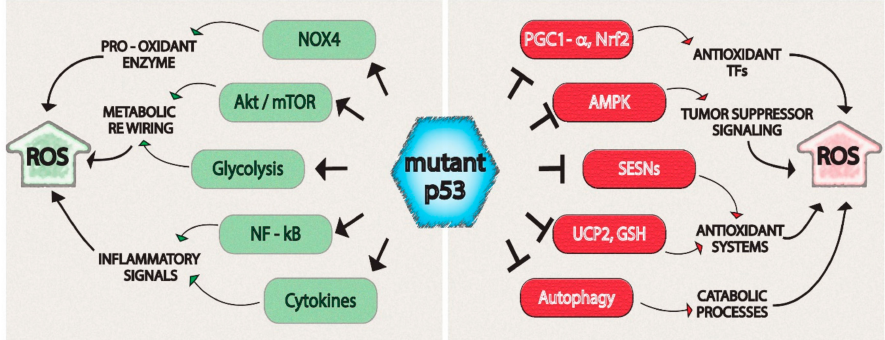
Figure 1. Gain-of-function mutant p53 orchestrates an oncogenic program that induces high levels of reactive oxygen species (ROS) to promote tumor